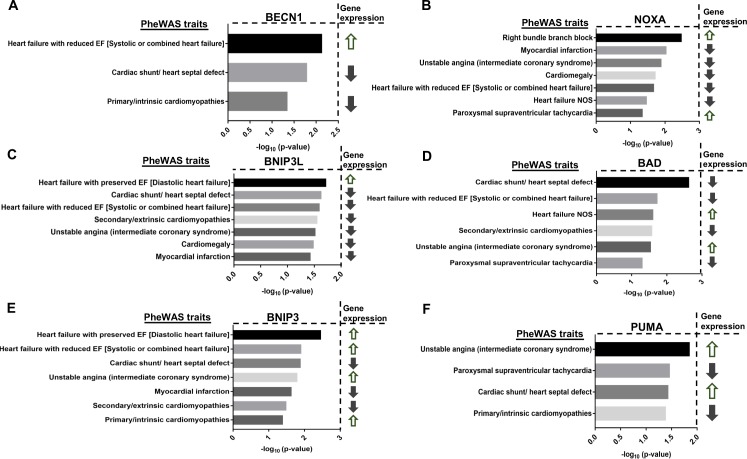
Secondary PrediXcan analysis of BH3-only Bcl-2 family genes shows discordant direction of effect with heart conditions.(A–F) Graphs of significant cardiac traits in the BioVU validation cohort ranked by p-values (-log10) for BECN1, NOXA, BNIP3L, BAD, BNIP3, and PUMA and the corresponding direction of gene expression. For all genes, cardiac traits that appeared more than once were represented in the graph by the most significant p-value. P-values were determined by logistic regression with disease status as response variable and imputed gene expression as predictor.